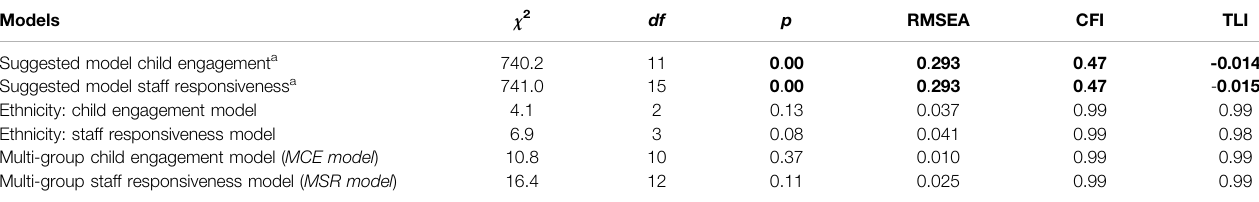
TABLE 4 | Fit parameters for the different models. Models Suggested model child engagement a